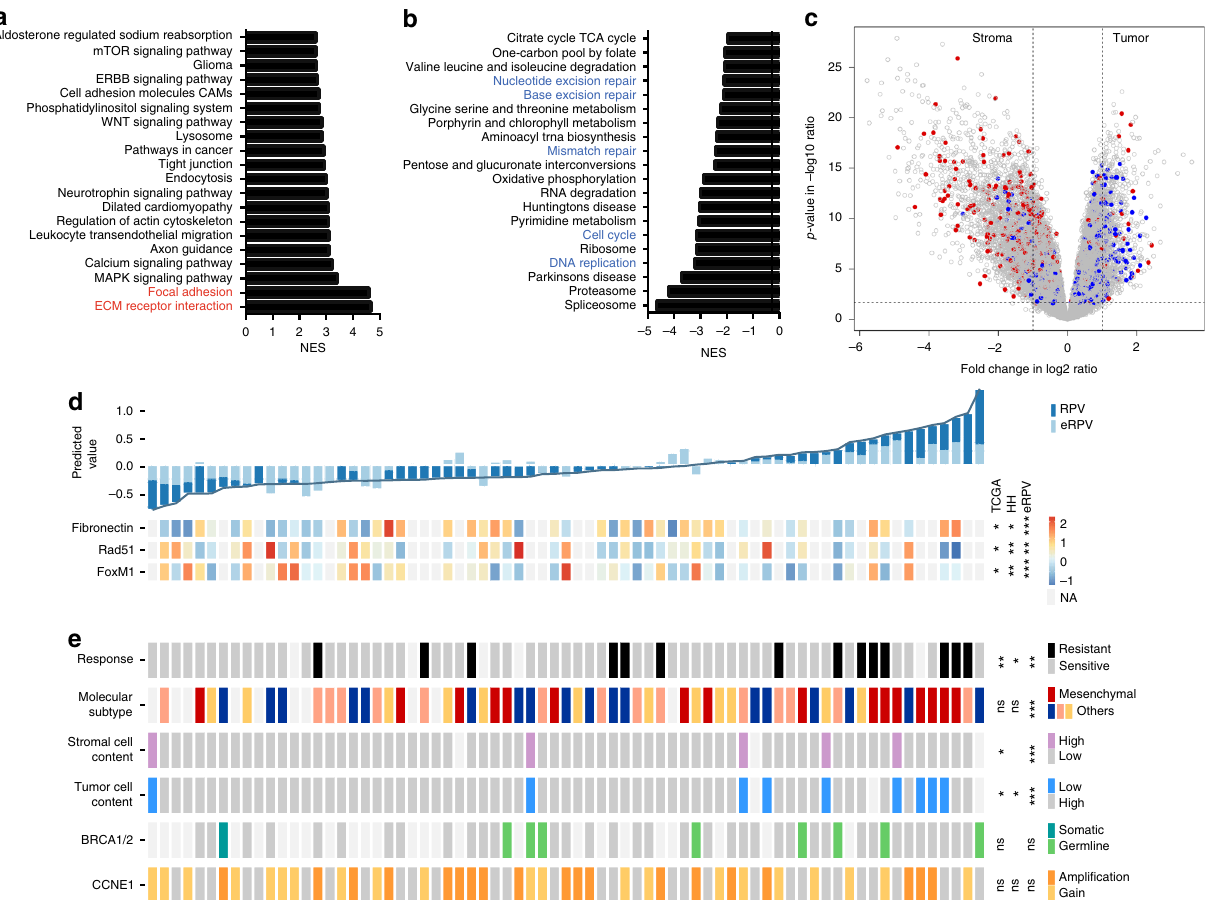
Fig. 3 Molecular characteristics associated with RPV in HGSOC. Gene set enrichment analysis identi fi ed a RPV-positively correlated biological pathways and b RPV-negatively correlated biological pathways from KEGG pathway database (FDR < 0.05). NES normalized enrichment score. c Volcano plot showing the differential expressed genes between stroma and tumor epithelial component from a public dataset, GSE40595. The genes that positively correlated with RPV are highlighted in red ( r > 0.3, Spearman correlation); genes that are negatively correlated with RPV are highlighted in blue ( r < − 0.3, Spearman correlation). d Heatmap showing correlation of protein expression (Fibronectin, Rad51 and FoxM1) with RPV for 47 cases in the TCGA validation dataset. The signi fi cance between these protein features with RPV was indicated for 119 cases in the HH cohort and with eRPV from 353 additional TCGA cases. Top panel, RPV ranked from low to high (left to right) and their corresponding eRPV (light blue). Lower panel, protein expression level of Fibronectin, Rad51 and FoxM1. p values are given by one-sided Spearman ’ s correlation test as validation of the transcriptomic analyses. e Clinical, histological and genetic characteristics associated with RPV in the TCGA and HH cohorts. Each rectangle block represents one patient in the TCGA validation dataset. The signi fi cance of association between these characteristics with RPV in the TCGA validation dataset, HH cohort and eRPV in additional TCGA dataset is indicated on the right side. The signi fi cance is indicated on the right from Kruskal − Wallis test (molecular subtype) or two-tailed Wilcoxon rank-sum test (others). The association between RPV and stromal component is shown in ( a ), ( c ), ( d ) and ( e ); The association between RPV and proliferation or DNA damage response is highlighted in ( b ) and ( d ). *** p < 0.001, ** p < 0.01, * p < 0.05, ns p > 0.1. RPV radiomic prognostic vector, HGSOC high-grade